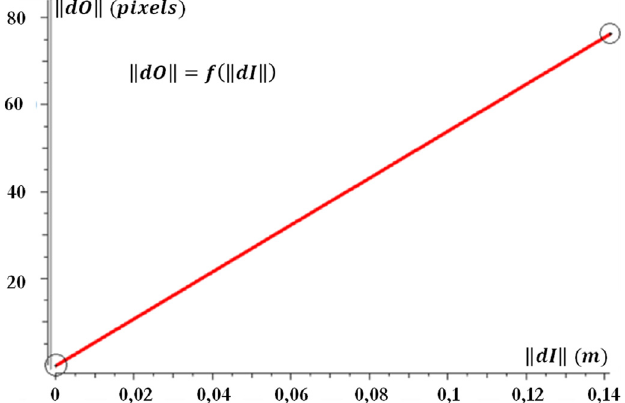
Fig. 25. Comparison between Monte-Carlo and intervals for estimating uncertainties ampli fi cation by the pinhole model.